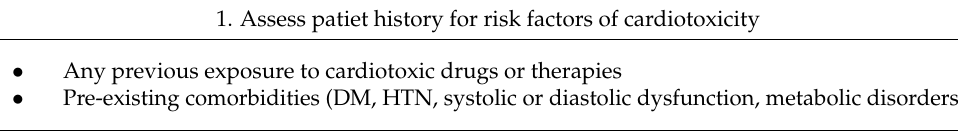
Table 2. Recommended work up of patients on cancer chemotherapy